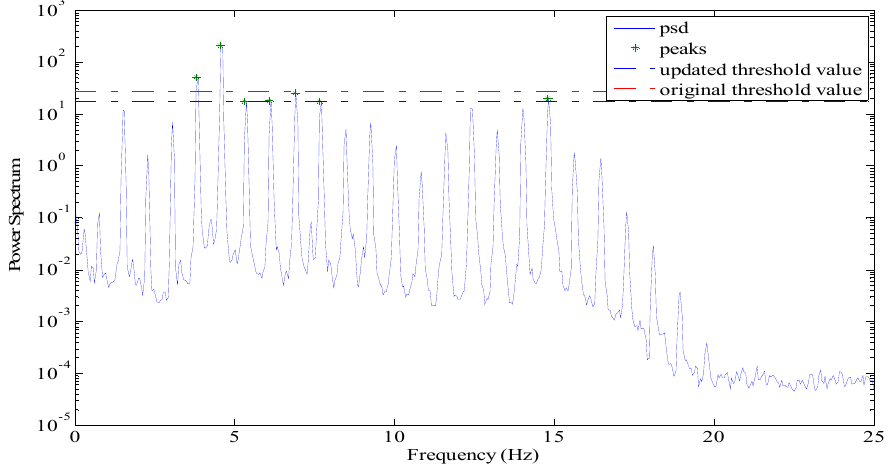
Figure 5. C3 Cable of Jindo Bridge on Haenam side.